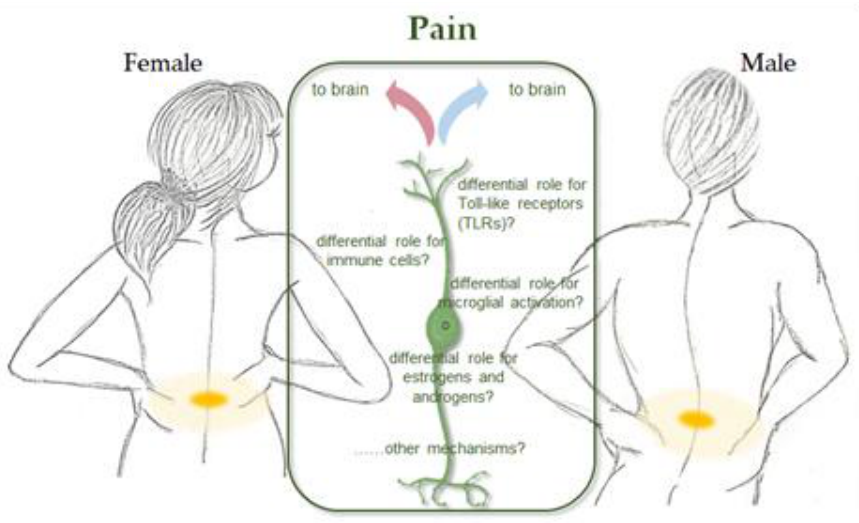
Figure 7. Hypothesis of various cellular mechanisms involving pain transmission in females and males.